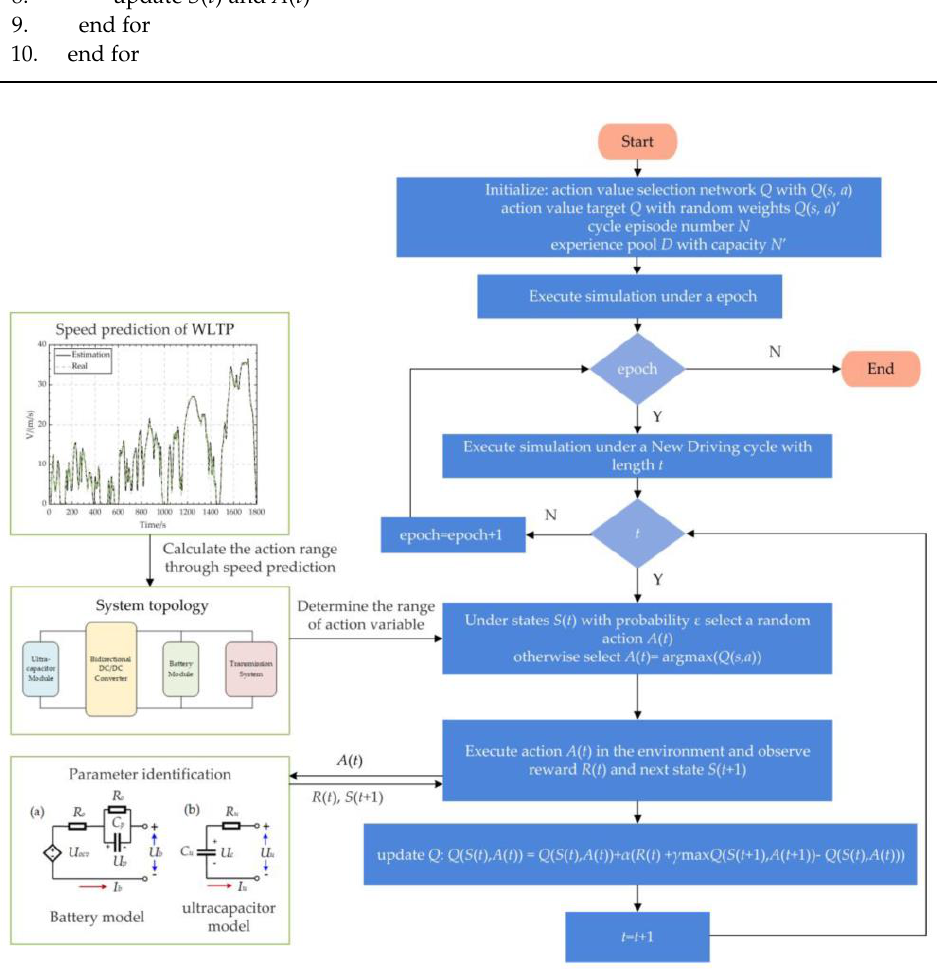
Figure 3. Algorithm block